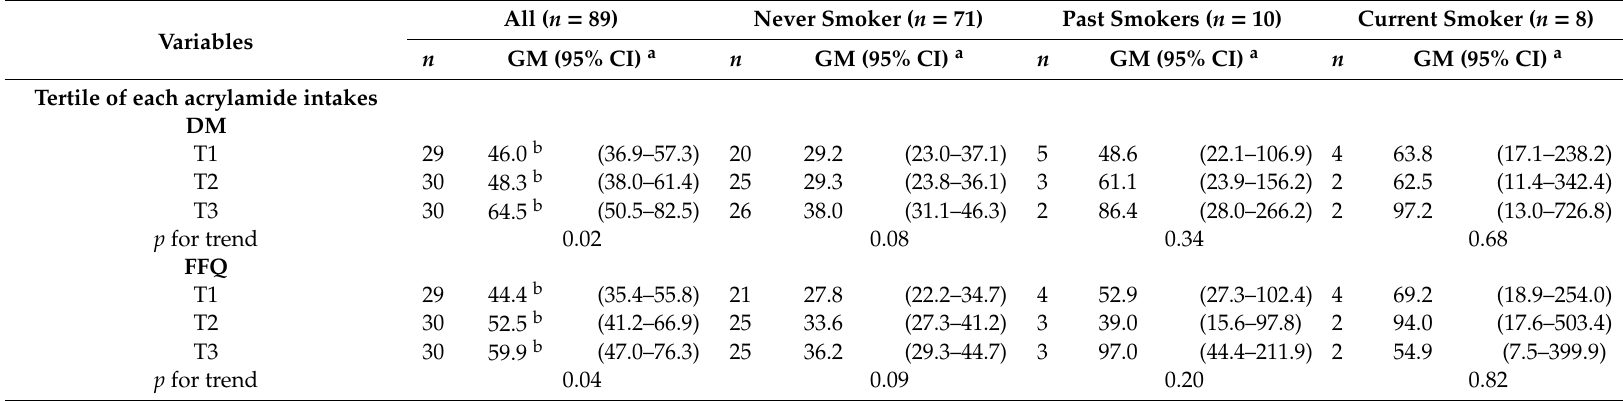
Table 3. GMs and 95% CI of acrylamide hemoglobin adduct level according to tertile of acrylamide intake estimated from DM and